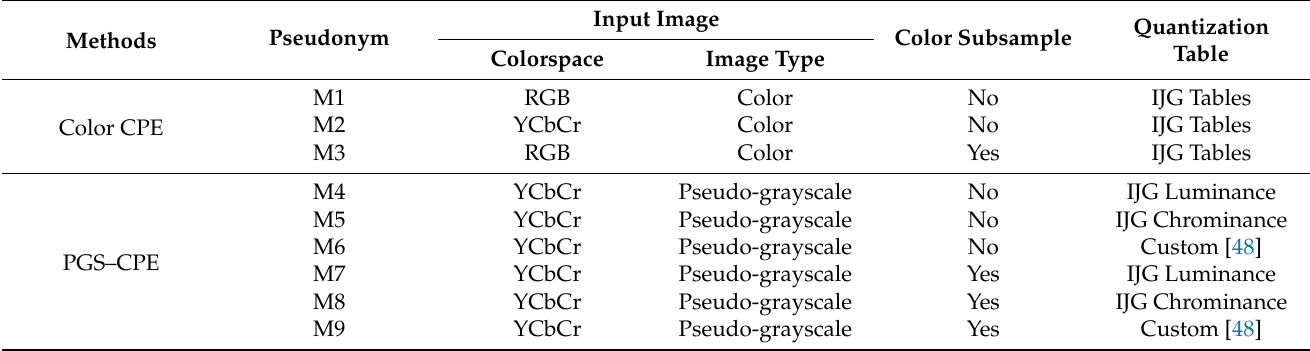
Table 5. CPE scheme implementation settings for color image encryption and